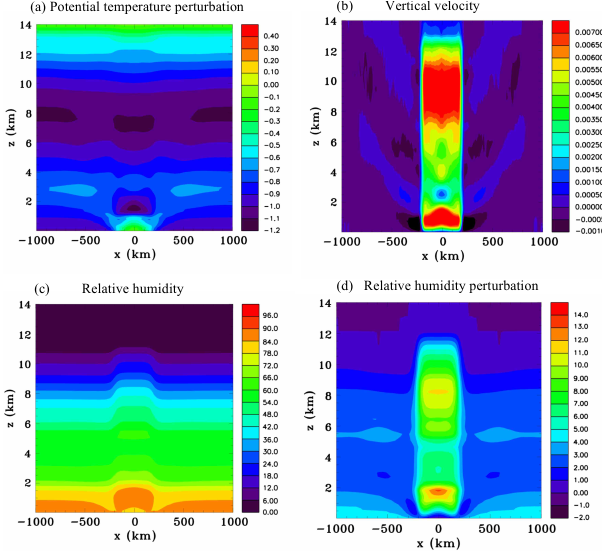
Figure 3. Vertical sections for Experiment 2: the maximum cooling aloft and weaker maximum at low-level case, at t = 12h. (a) Poten- tial temperature perturbation (K), (b) vertical velocity (ms − 1 ), (c) relative humidity, and (d) relative humidity